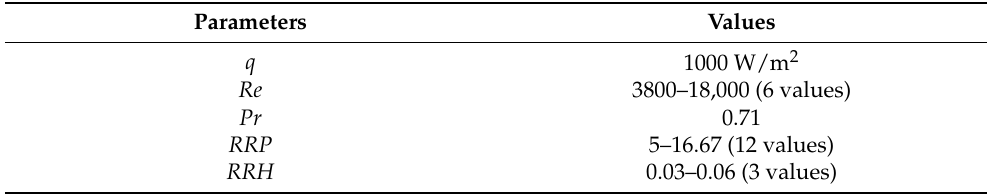
Table 1. Geometric parameters (all in mm) of ribbed SAH duct.